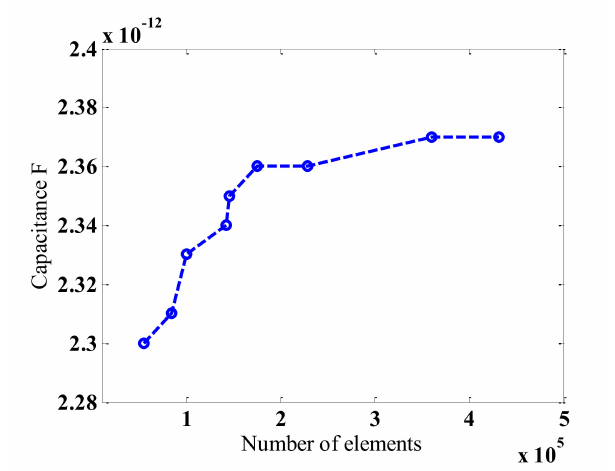
Figure 4. The number of finite points versus the measured capacitance